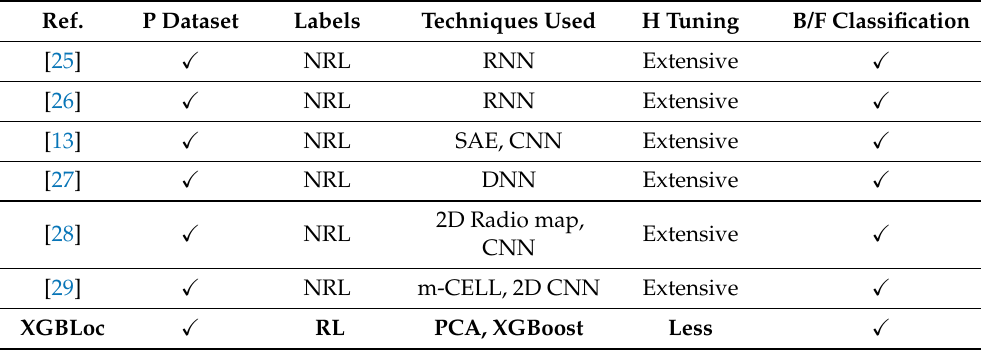
Table 1. Summary of recent related works. [Note] P Dataset: public dataset used, H tuning: hyperpa- rameter tuning required, B/F Classification: building and floor